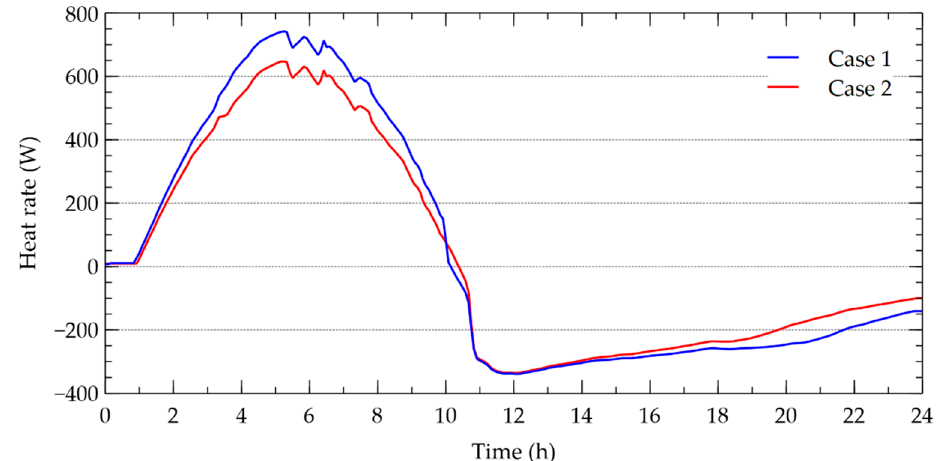
Figure 15. Estimated stored heat rate.